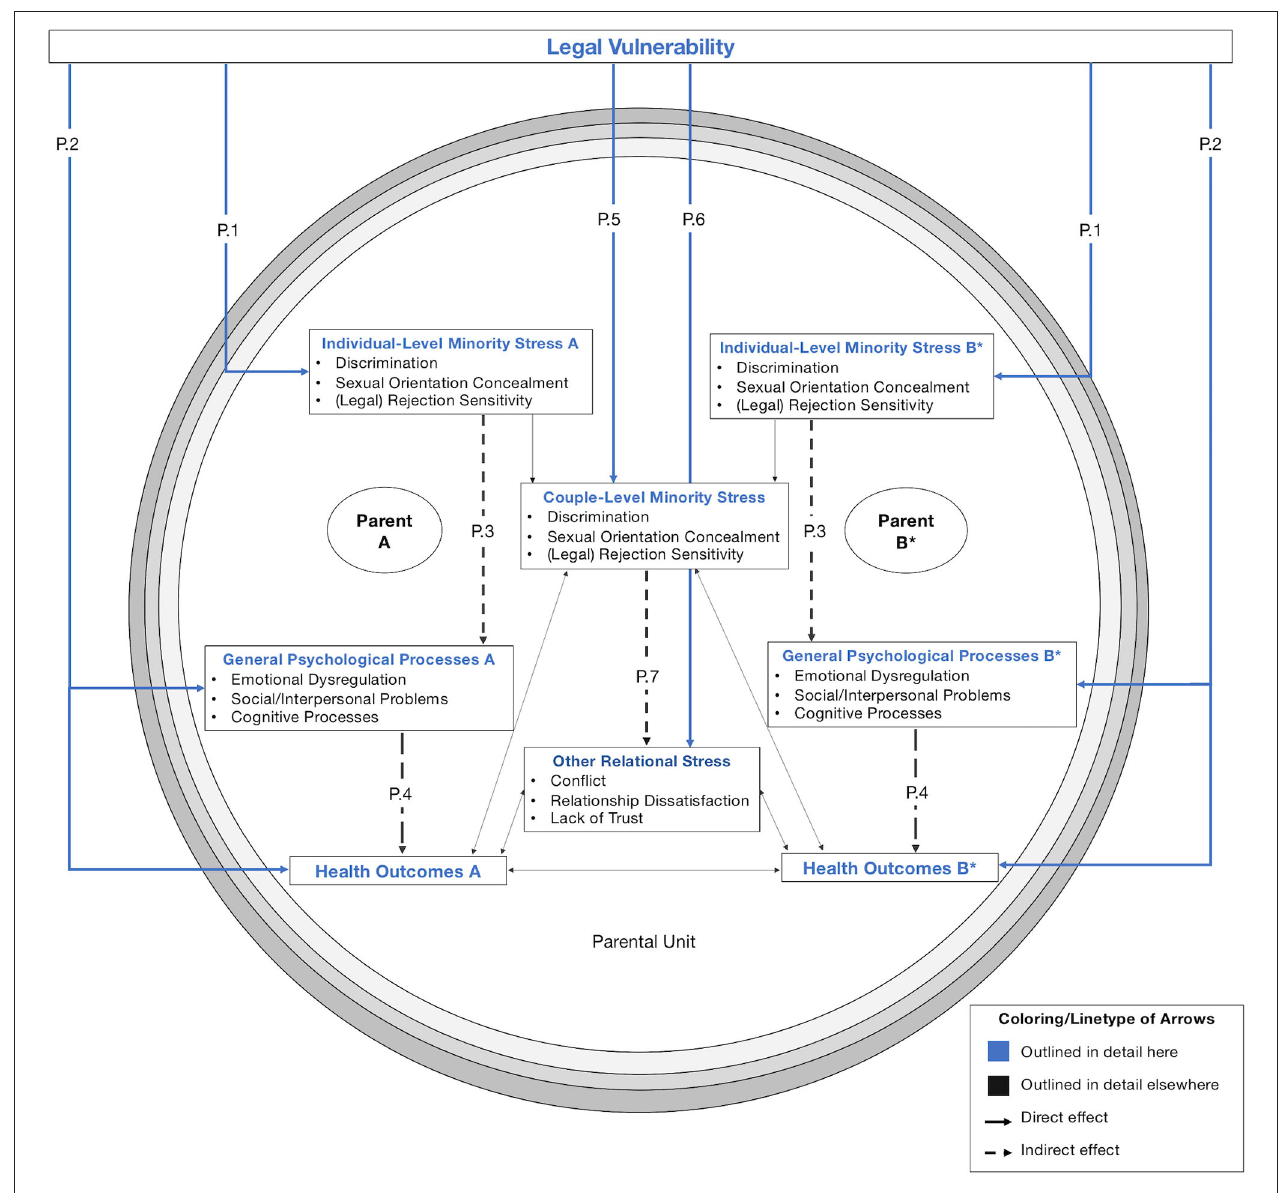
FIGURE 3 | Impact of legal vulnerability on parental health. Colored arrows (blue) are outlined in detail here and depict empirically testable relations between constructs (highlighted with colored headings), not evidence strength. Dashed lines depict indirect effects of legal vulnerability (i.e., through other constructs). Thin, unlabeled arrows (e.g., between other relational stress and health outcomes) depict interrelations between constructs outlined in detail elsewhere. Note that legal vulnerability is depicted outside the parental unit for clarity. Terminology was chosen in line with Feinstein (2020), Hatzenbuehler (2009), LeBlanc et al. (2015), and Meyer (2003). *Nonlegal status to child and/or